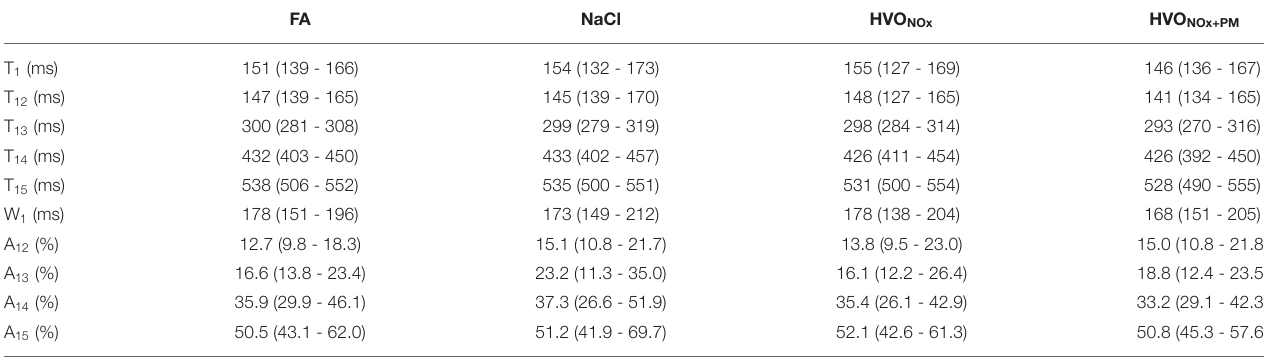
TABLE 1 | Median and interquartile range (Q 1 –Q 3 ) of pre-exposure PDA features for each exposure scenario.